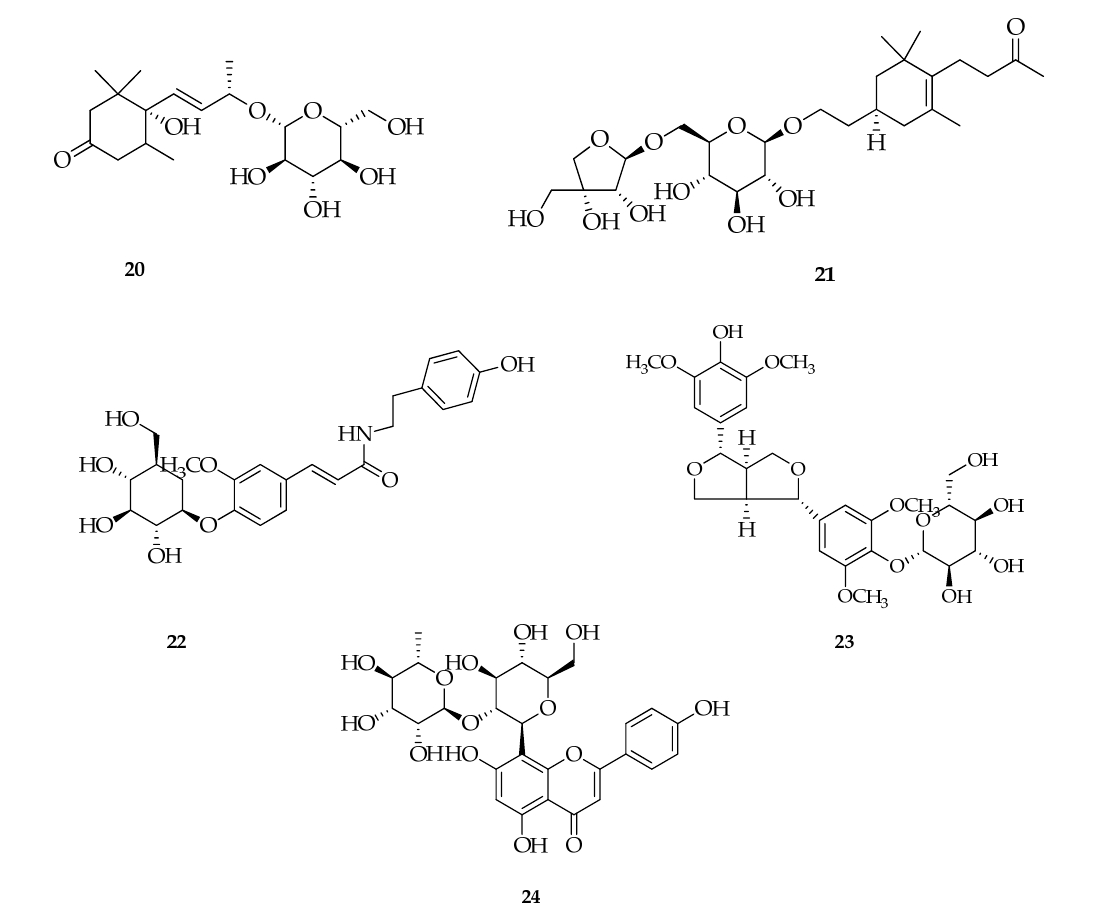
Figure 5. Compounds obtained from the methanol extract of red betel leaf. ( 1 ) (8 R )-8-(4-hydroxy-3,5-dimethoxy)-propane-8-ol-4- O - β - D- glucopyranoside; ( 2 ) 4-Allyl-2,6-dimethoxy-3-hydroxy-1- D -glucopyranoside; ( 3 ) 3-[(1 E )-3-hydroxy-1-propen-1-yl]-2,5-dimethoxyphenyl- D -glucopyranoside; ( 4 ) Cimidahurinin; ( 5 ) Erigeside II; ( 6 ) Syringe; ( 7 ) β -phenylethyl- β - D -glucoside; ( 8 ) Methylsalicylate-2- O - β - D -glucopyranoside; ( 9 ) Icariside D1; ( 10 ) 4-Hydroxybenzoic acid- D -glucosylester; ( 11 ) Benzyl- β - D -glucoside; ( 12 ) Phenylmethyl-6- O - α - L -arabinofuranosyl- β - D -glucopyranoside; ( 13 ) Hydroxytyrosol-1glucopyranoside ( 14 ) Gentisic acid; ( 15 ) Catechaldehyde; ( 16 ) ( S )-Menthiafolic acid; ( 17 ) Ioliolide; ( 18 ) 5 β ,6 β -dihydroxy-3 α -( β - D -glucopyranosyloxy)-7 E -Megastigmen-9-one; ( 19 ) (3 E )-4-[(1 S ,2 S ,4 S )-4-( β - D -glucopyranosyloxy)-1,2-dihydroxy-2,6,6-tri-methylcyclohexyl]3-buten-2-one; ( 20 ) (6 S ,9 S )-roseoside; ( 21 ) Cuneataside E ( 22 ) N -trans-feruloyltyramine-4 ′ - O - β - D -glucopyranoside; ( 23 ) Syringaresinol- β - D -glucoside; and ( 24 ) Vitexin 2 ″ - O -rhamnoside.